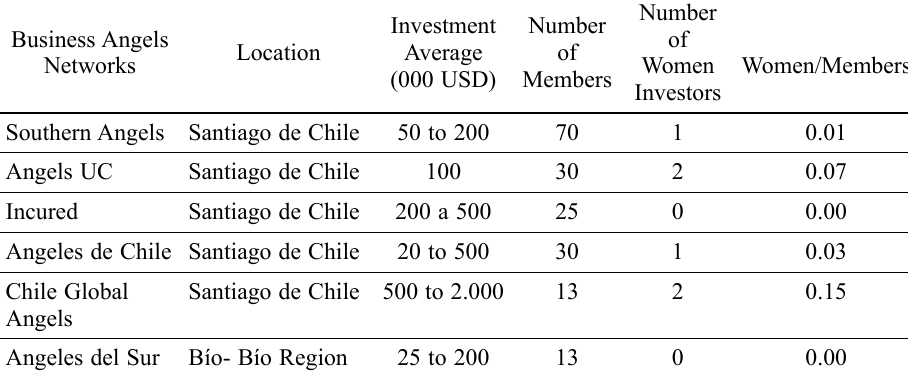
Table 2. Summary of the main characteristics of Angel investor networks in Chile (2009) Business